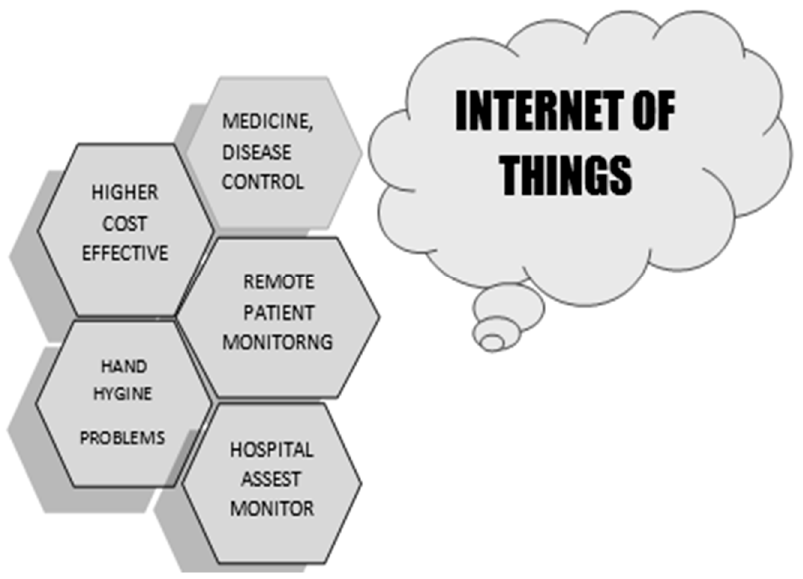
Figure 6. IoT Medical services .